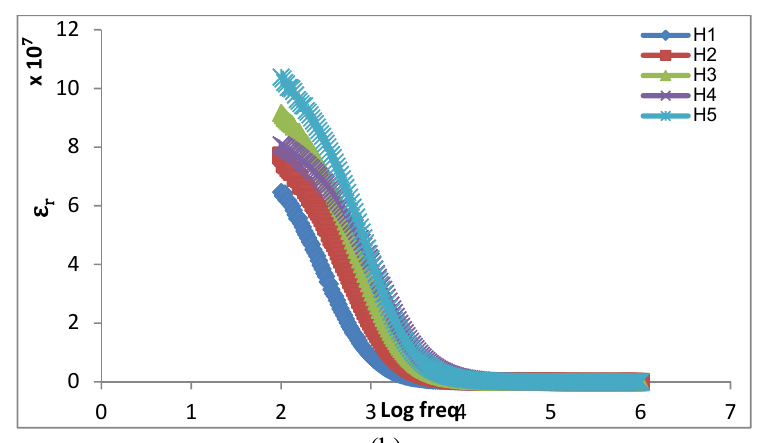
Fig.3: Dielectric constant vs. Log frequency at RT with different salts concentration for electrolytes, (b)